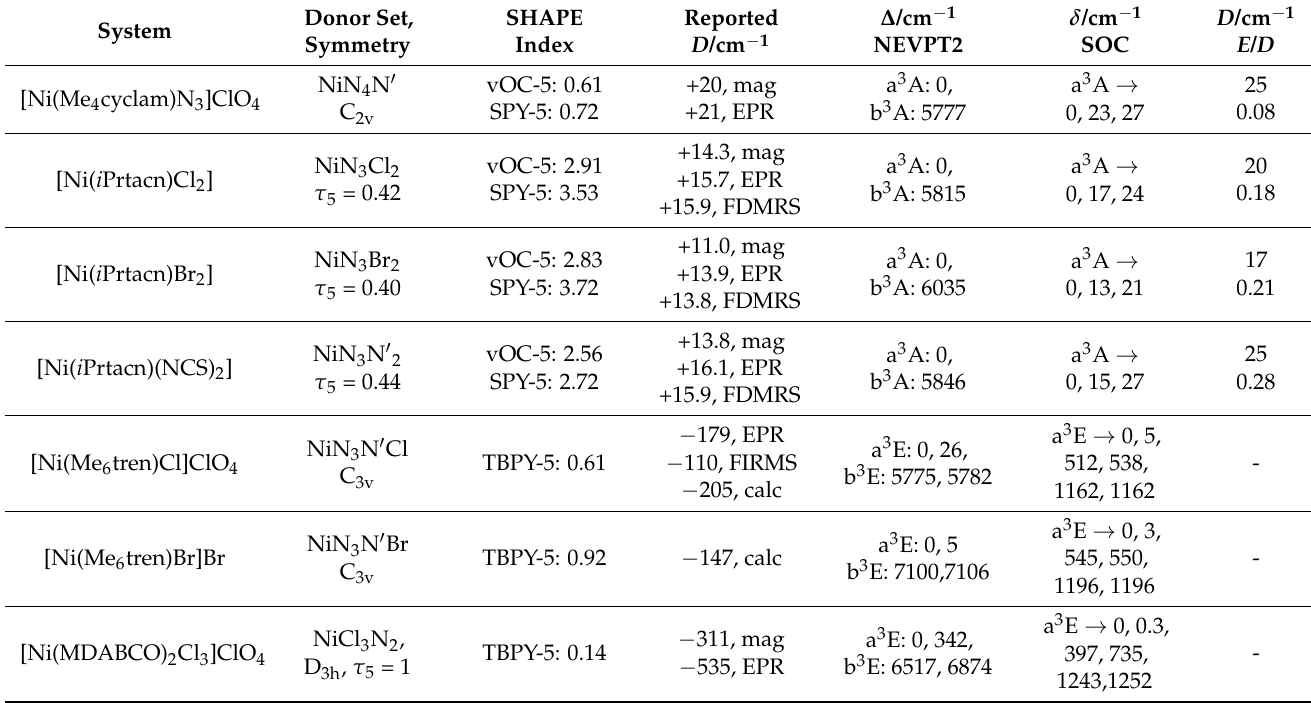
Table 5. Energy levels for representative Ni(II) complexes calculated by ab initio method